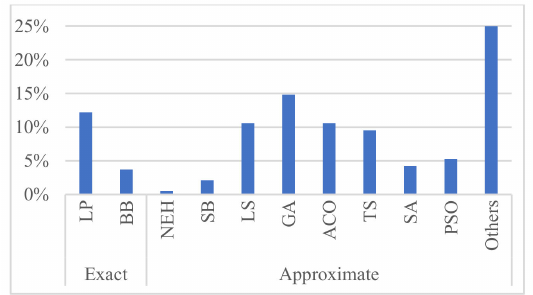
Figure 26. Percentage of different types of solution methods in the dataset. Linear programming (LP) and genetic algorithm (GA) are the most applied exact and approximate methods with 12.2% and 14.8% frequency among the data.